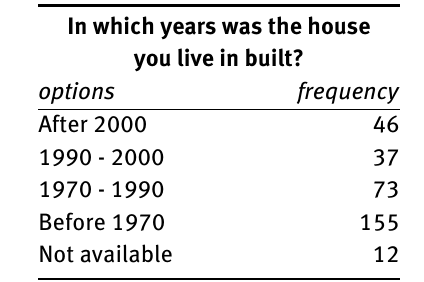
Table 9: Distribution among Italian regions where questionnaires have been filled